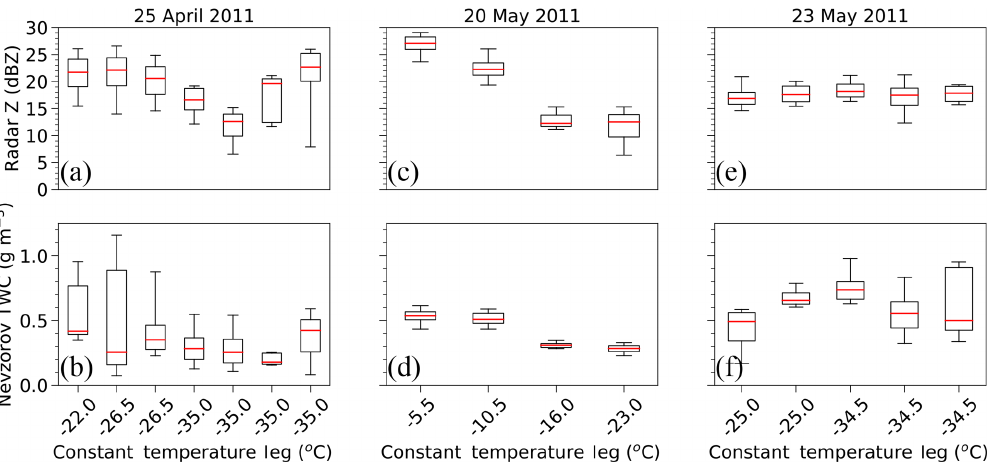
Figure 6. Distribution of matched Z (a, c, e) and TWC from the Nevzorov probe (b, d, f) for each constant-temperature leg on 25 April (a, b) , 20 May (c, d) , and 23 May 2011 (e, f) . Whiskers represent the 5th and 95th percentiles, box edges are the 25th and 75th percentiles, and the line in the middle is the median. Cases where multiple legs of the same temperature exist are shown in chronological order.